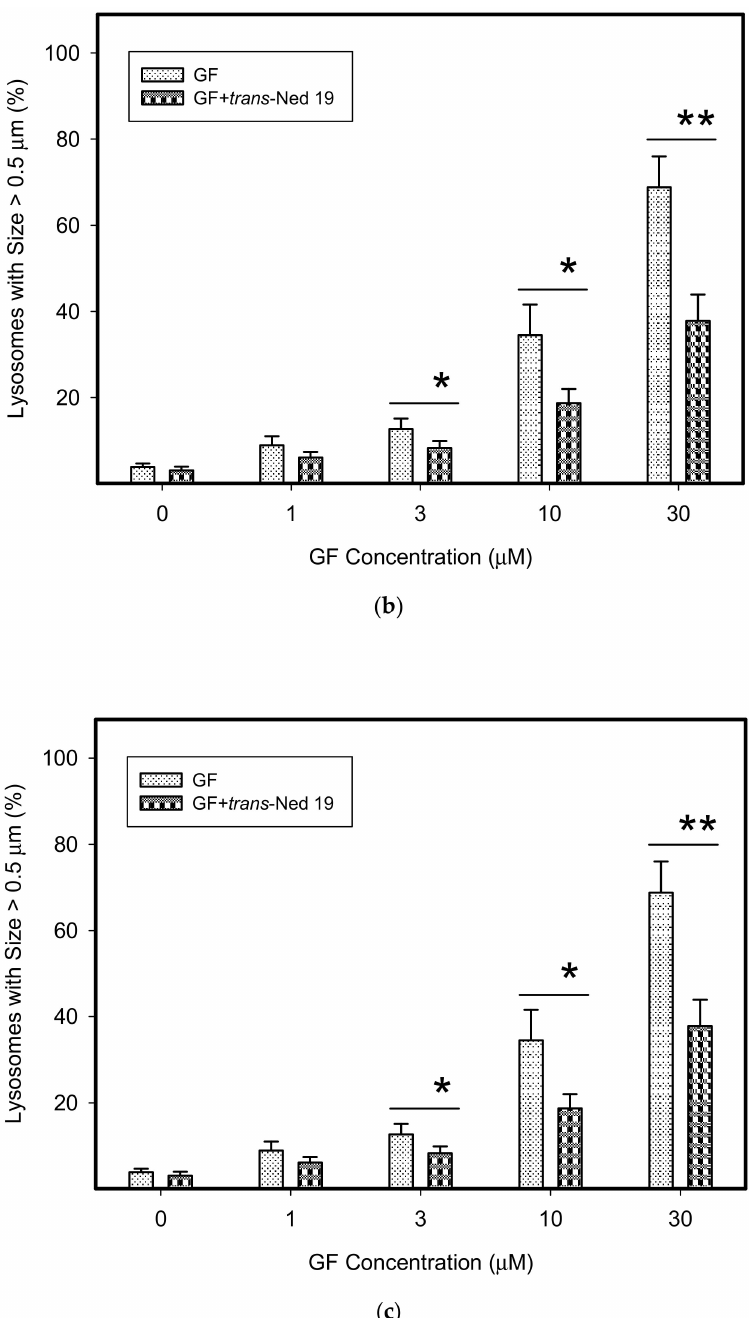
Figure 8. E ff ect of NAADP antagonist, trans -Ned 19, on lysosomal morphology in HL-60 cells treated with TKIs. Cells were cultured for 6 h in the presence of particular TKI with or without 10 µ M trans -Ned 19 under standard conditions and then fixed in paraformaldehyde and subjected to the immunostaining of LAMP1. Cells cultured in medium without TKIs were taken as a control. ( a ) Morphologic changes in lysosomes of HL-60 cells (typical analysis). ( b ) Quantitative analysis of lysosomal size in GF treated HL-60 cells. ( c ) Quantitative analysis of lysosomal size in IM treated HL-60 cells. Lysosomal morphology was evaluated in at least 250 cells for each treatment. Results are shown as means of four independent experiments with standard deviations. * denotes significant change in the number of lysosomes with size > 0.5 µ m ( p < 0.05) between cells treated with TKI and cells treated with TKI + trans -Ned 19. ** denotes significant change in the number of lysosomes with size > 0.5 µ m ( p < 0.01) between cells treated with TKI and cells treated with TKI + trans -Ned